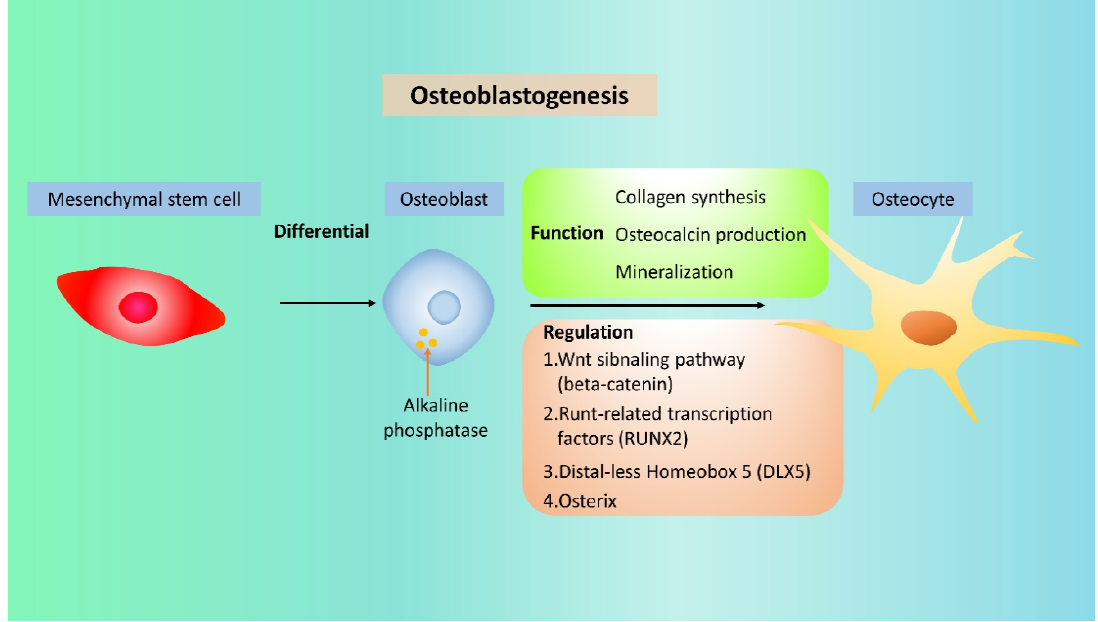
Figure 2. The differentiation and regulation in the osteoblastogenesis process. In the Figure 2. The di ff erentiation and regulation in the osteoblastogenesis process. In the osteoblastogenesis, osteoblastogenesis, osteocytes are derived from mesenchymal stem cell then osteoblast which osteocytes are derived from mesenchymal stem cell then osteoblast which regulated by beta-catenin, regulated by beta-catenin, Runt-related transcription factor 2 (RUNX2), Distal-Less Homeobox 5 Runt-related transcription factor 2 (RUNX2), Distal-Less Homeobox 5 (DLX5), and osterix. The collagen (DLX5), and osterix. The collagen synthesis, osteocalcin production, and mineralization let the synthesis, osteocalcin production, and mineralization let the osteoblasts formulate the osteocytes. osteoblasts formulate the osteocytes. Bone remodeling is a continuous balance between bone absorption and bone formation